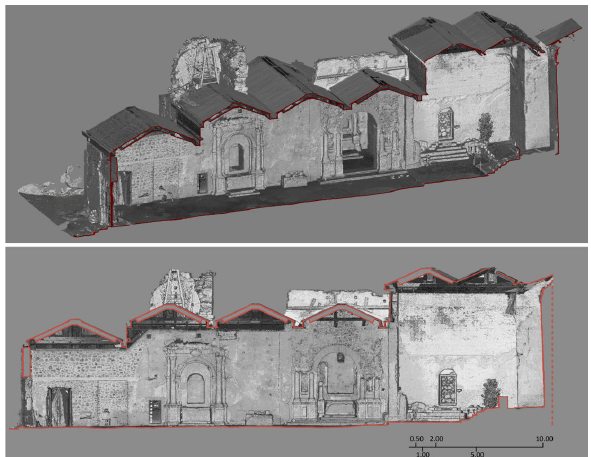
Figure 3. Longitudinal cross section of the church of Santa Maria delle Grazie (ancient Misterbianco) in 3D and ortographic view of the point cloud in grey